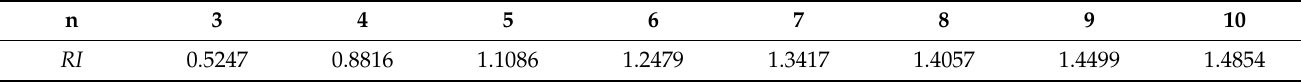
Table 5. Random consistency index values for computing the consistency ratio